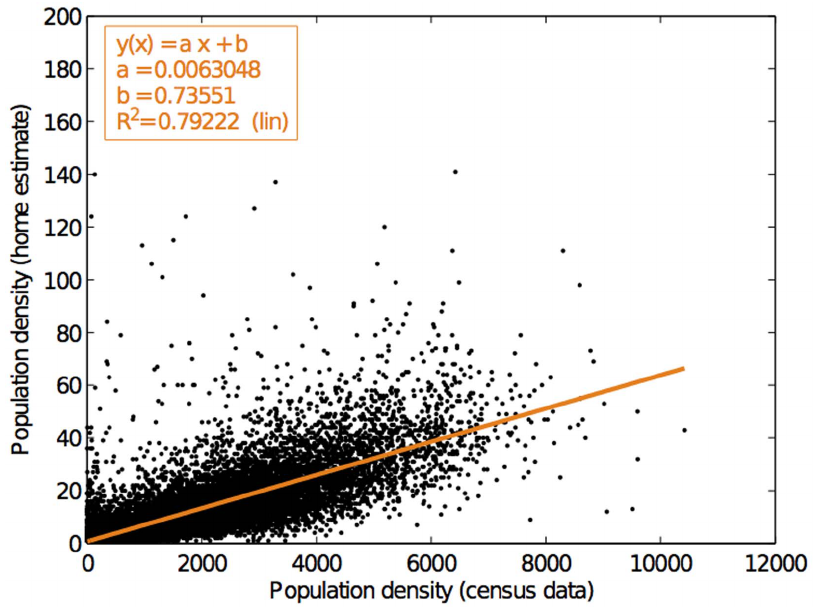
Figure 6. Comparison between our inferred residential municipality population of the mobile phone user subjects and the actual municipality population obtained from census data.